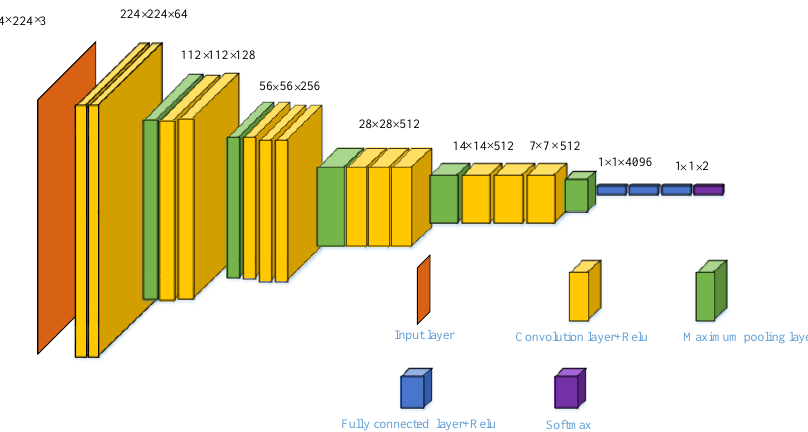
Figure 2. VGG16 structure model.